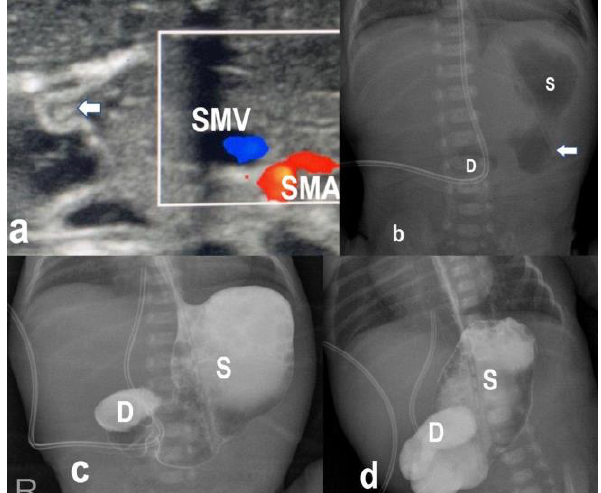
Figure 3: a) Postnatal transverse ultrasonography with color